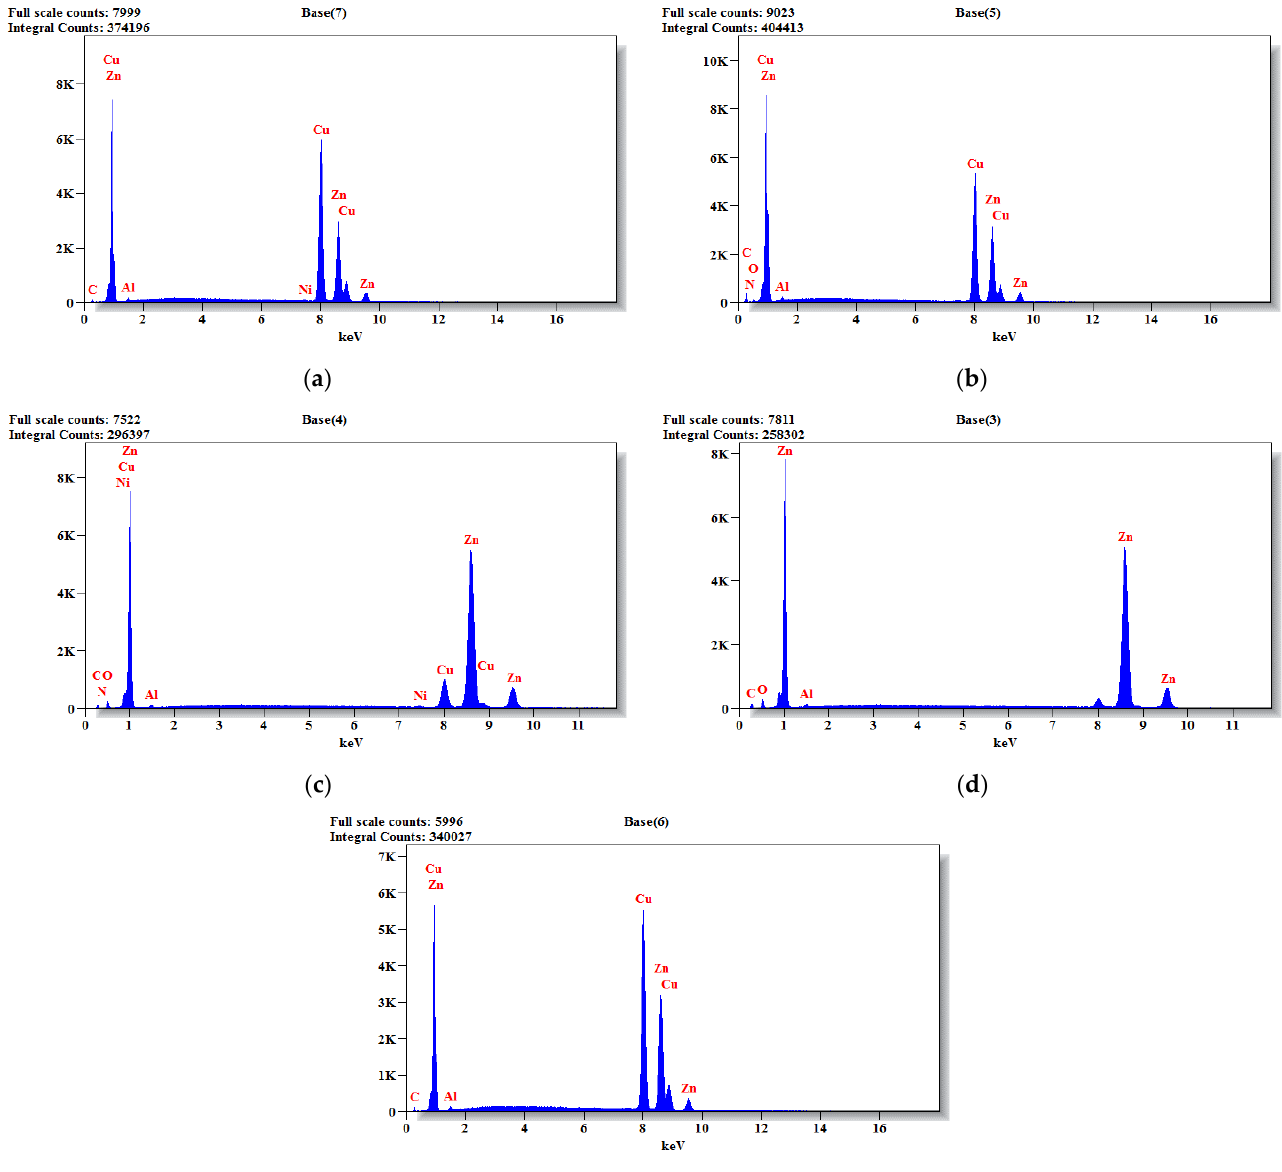
Figure 21. EDS Results of brass fibre subjected to elevated temperatures. ( a ) Room temperature; ( b ) 200 °C; ( c ) 400 °C; ( d ) 600 °C; ( e ) 800